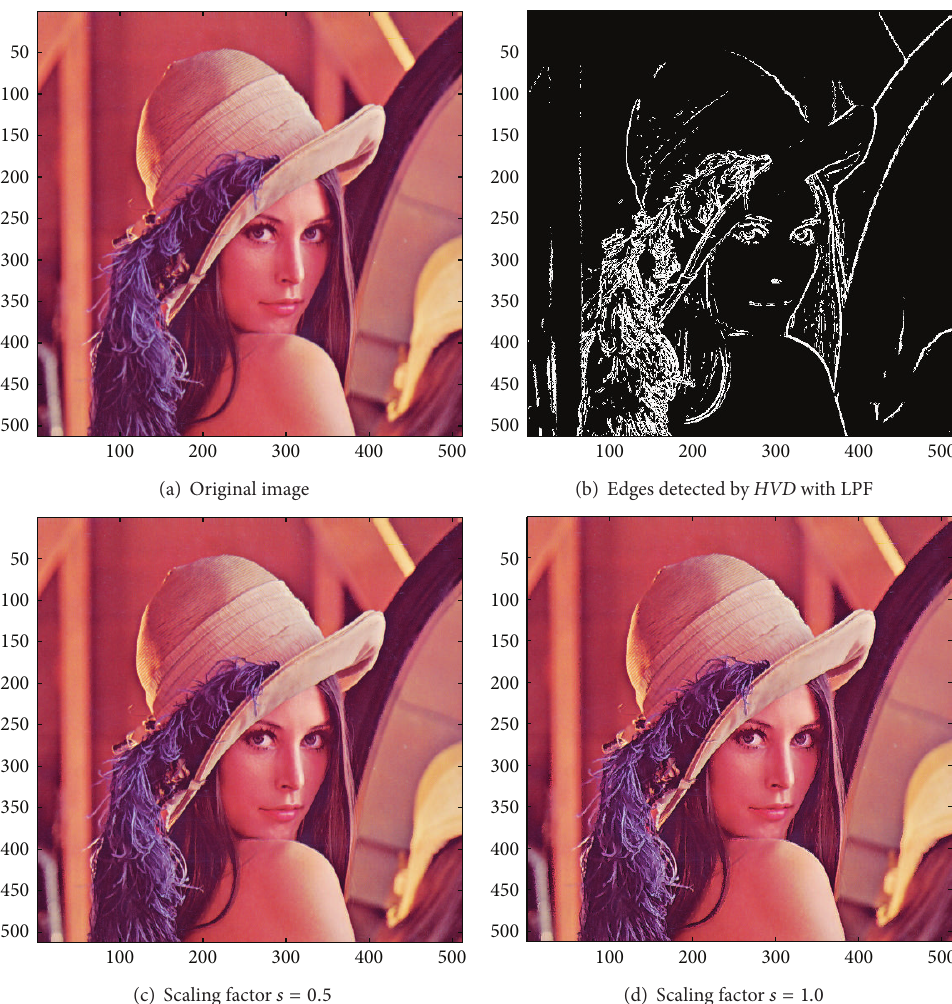
= 16 for HVD . (a) The image “Lena” (512 × 512 color image). (b) Edges detected by HVD with LPF. (c and d) Sharpened results Figure 9: 𝜃 eth by HVD with scaling factors 0.5 and 1.0 ,